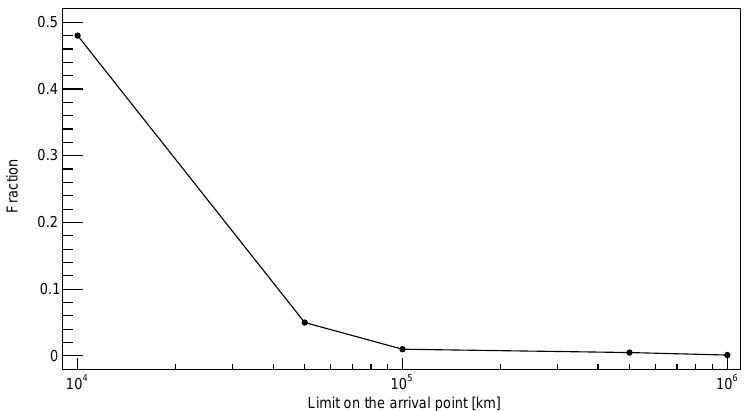
Figure 6. The graph of the fraction of simulations, for which at least some secondary photons reached the Earth’s atmosphere, in all simulations that fulfilled the arrival point limit.